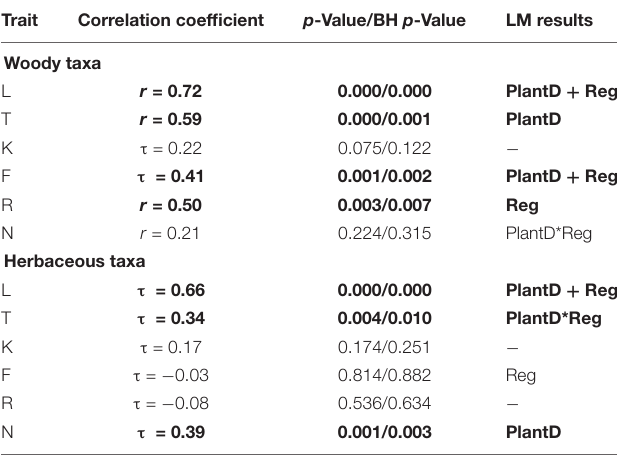
TABLE 5 | Results of correlation tests between pollen-plant based Ellenberg indicators (EIVs) of light (L); temperature (T); continentality (K); moisture (F); soil pH reaction (R); nutrient availability (N) for woody and herbaceous